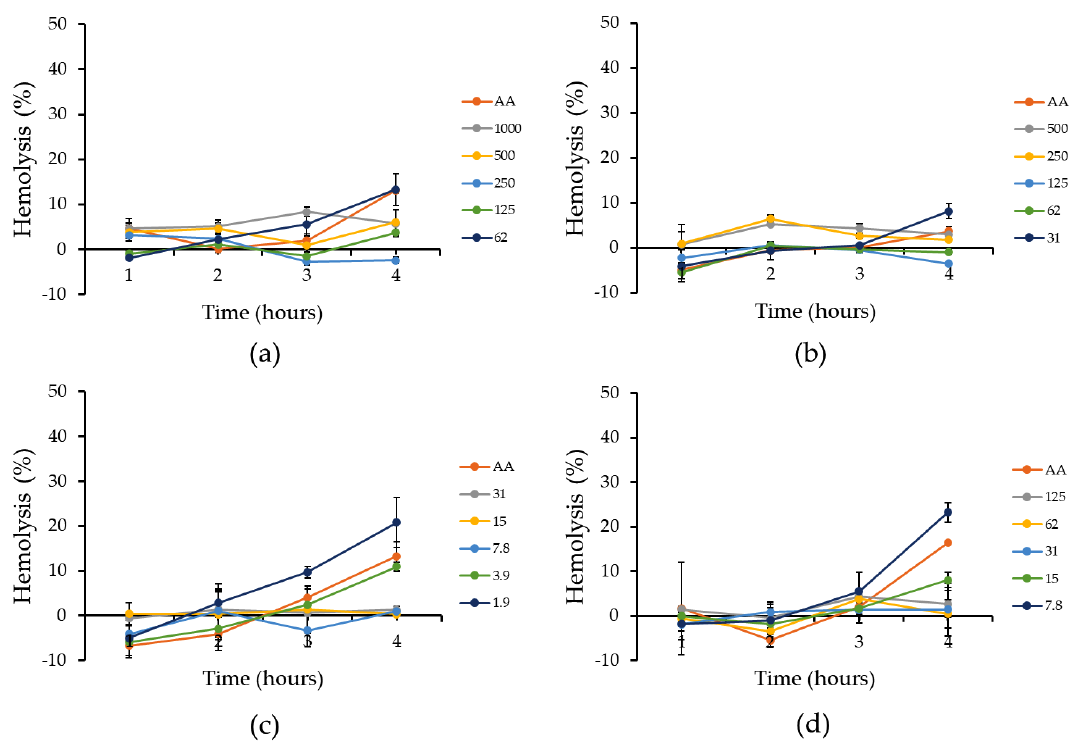
Figure 2. Effect of JWE and fractions (JWF1-3) on hematoprotection of RBCs against oxidative stress. RBCs were treated with several concentrations (µg.mL −1 ) of the extracts and challenged with 7 mM AAPH (OC 50 ) for 4 h. Hematoprotective (antioxidant) effect of ( a ) JWE; ( b ) JWF1; ( c ) JWF2; and ( d ) JWF3. Ascorbic acid (AA) at 6 µM was used as a reference antioxidant agent. Each point represents the mean of two independent experiments ± standard error.